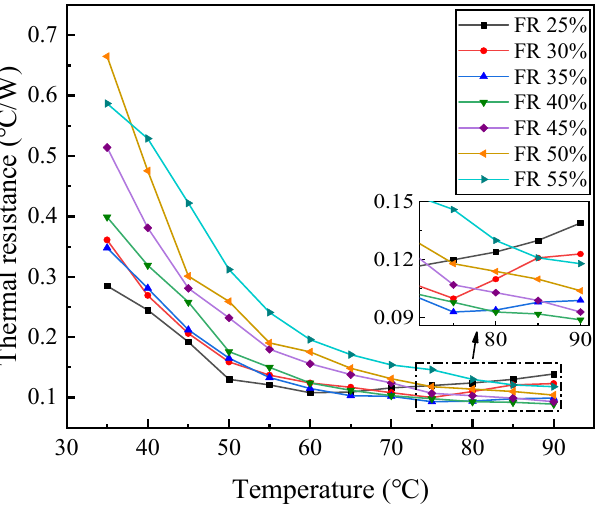
Figure 2. Thermal resistance versus temperature for different filling ratios. The flat-plate CLPHP is formed by merging two thin flat plates, and the degree of internal flow channel closure is affected by the internal vacuum pressure. Figure 3 shows the change curve of the relative pressure inside CLPHP with filling ratio when the heating temperature of the evaporation section is 80 ◦ C and 90 ◦ C. The internal relative pressure at 90 ◦ C is higher than that at 80 ◦ C. As the filling ratio increases, the internal relative pressure gradually increases, and it changes approximately linearly. When the filling ratio is 40% and the evaporation section heating temperature is 90 ◦ C, the relative pressure is -39 kpa. The lower vacuum pressure ensures the closure degree of the two plates of the flat-plate CLPHP, avoiding the plate bulging and flow channel damaging due to the positive pressure